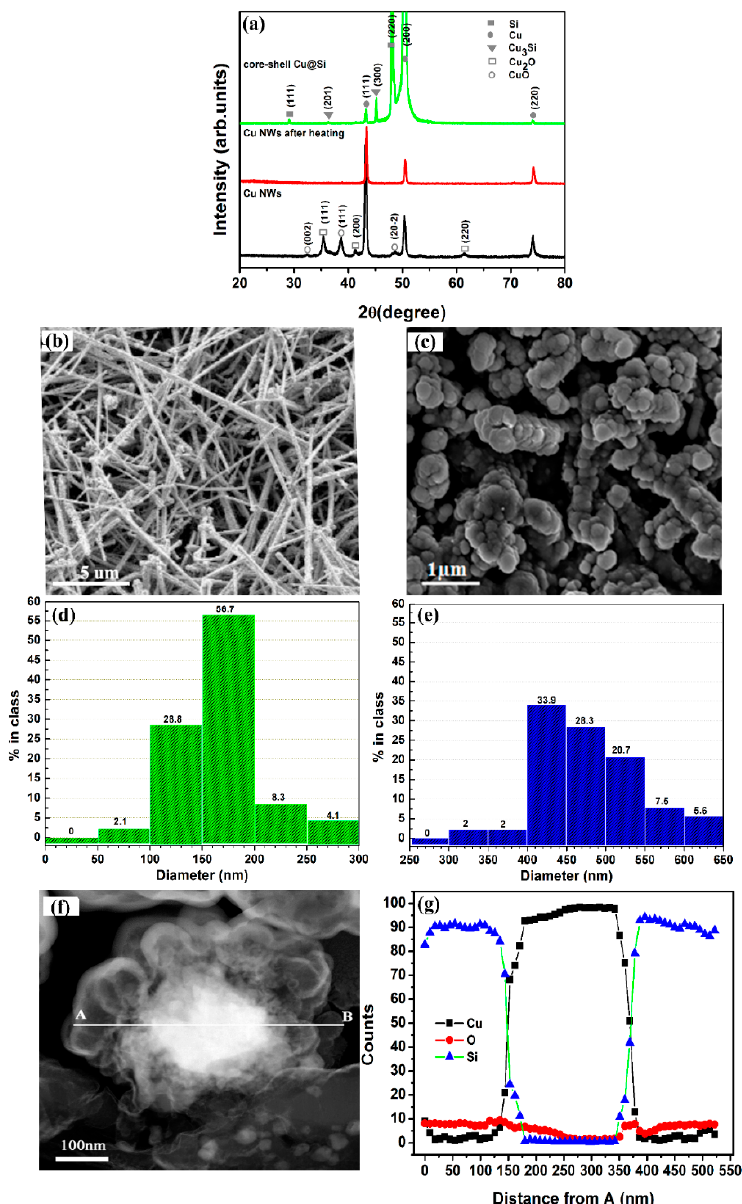
Figure 2. ( a ) XRD pattern of the as-received Cu nanowire on a Cu foil substrate before and after heat treatment at 280 °C for 2 h in a reductive atmosphere of 95 v.% Ar + 5 v.% H2, with and without Si deposition; ( b ) SEM image of the Cu nanowire (NW)-coated Cu foil substrate after heating treatment and the corresponding size distribution of the diameter of the Cu nanowire before ( b , d ) and